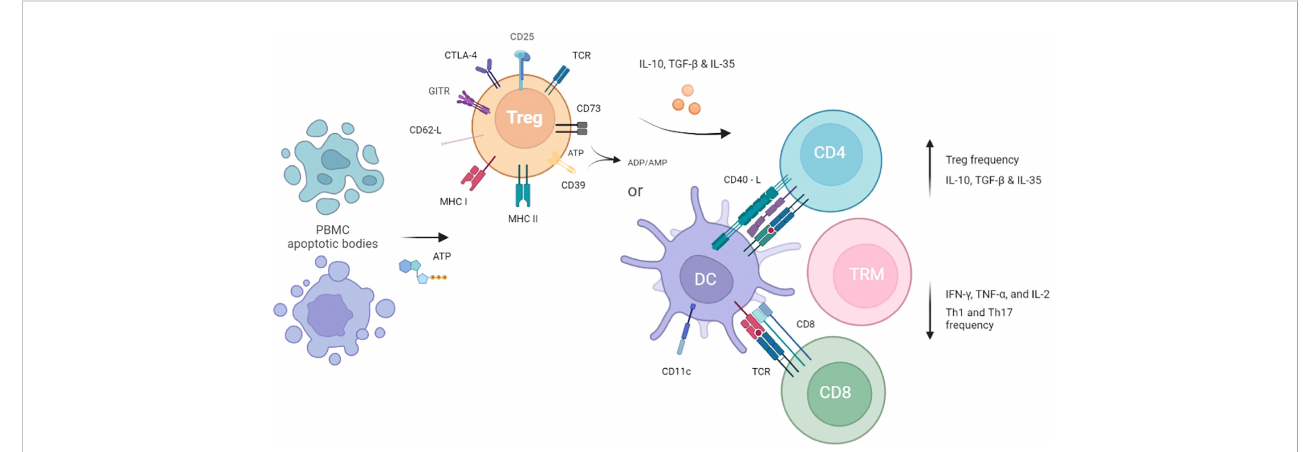
FIGURE 2 Hypothesised mechanism of ECP and tolerogenic immune cells immunosuppressive effects. The effect of ECP is fi rst seen in the blood compartment where a portion of PBMCs go into apoptosis. Apoptotic bodies released by the PBMCs circulate and interact with Tregs as well as tissue-resident cells such as DCs, leading to tolerisation. Immunosuppression is achieved through cytokine excretion and cell-to-cell contact with mediators of GvHD such as CD4+ T helper cells, CD8+ T cells, and Tissue Resident Memory T